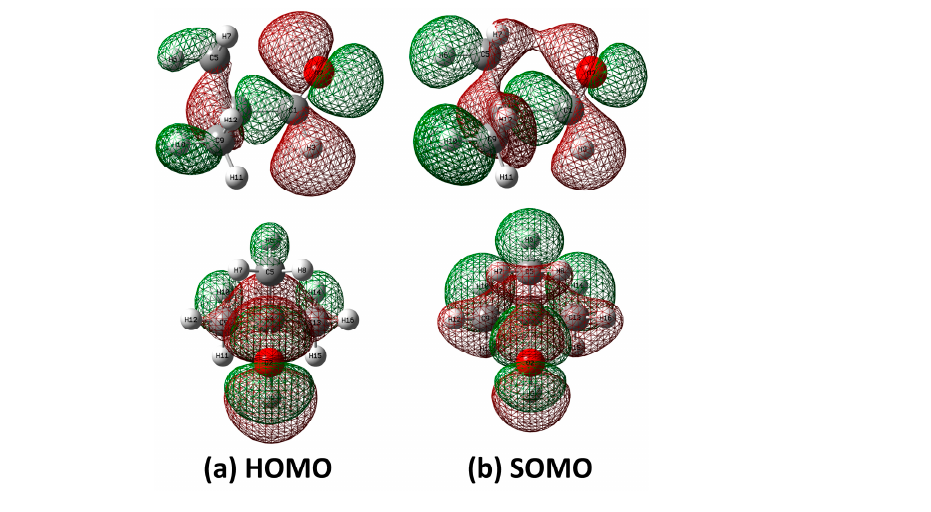
Figure 6. ( a ) HOMO of pivaldehyde with 2O–1C–4C–5C dihedral angle of 2.1° in S 0 and ( b ) singly occupied molecular orbital (SOMO) of pivaldehyde in D 0 state obtained at ω B97XD/cc-pVTZ level. HOMO and SOMO were obtained from NBO analysis.